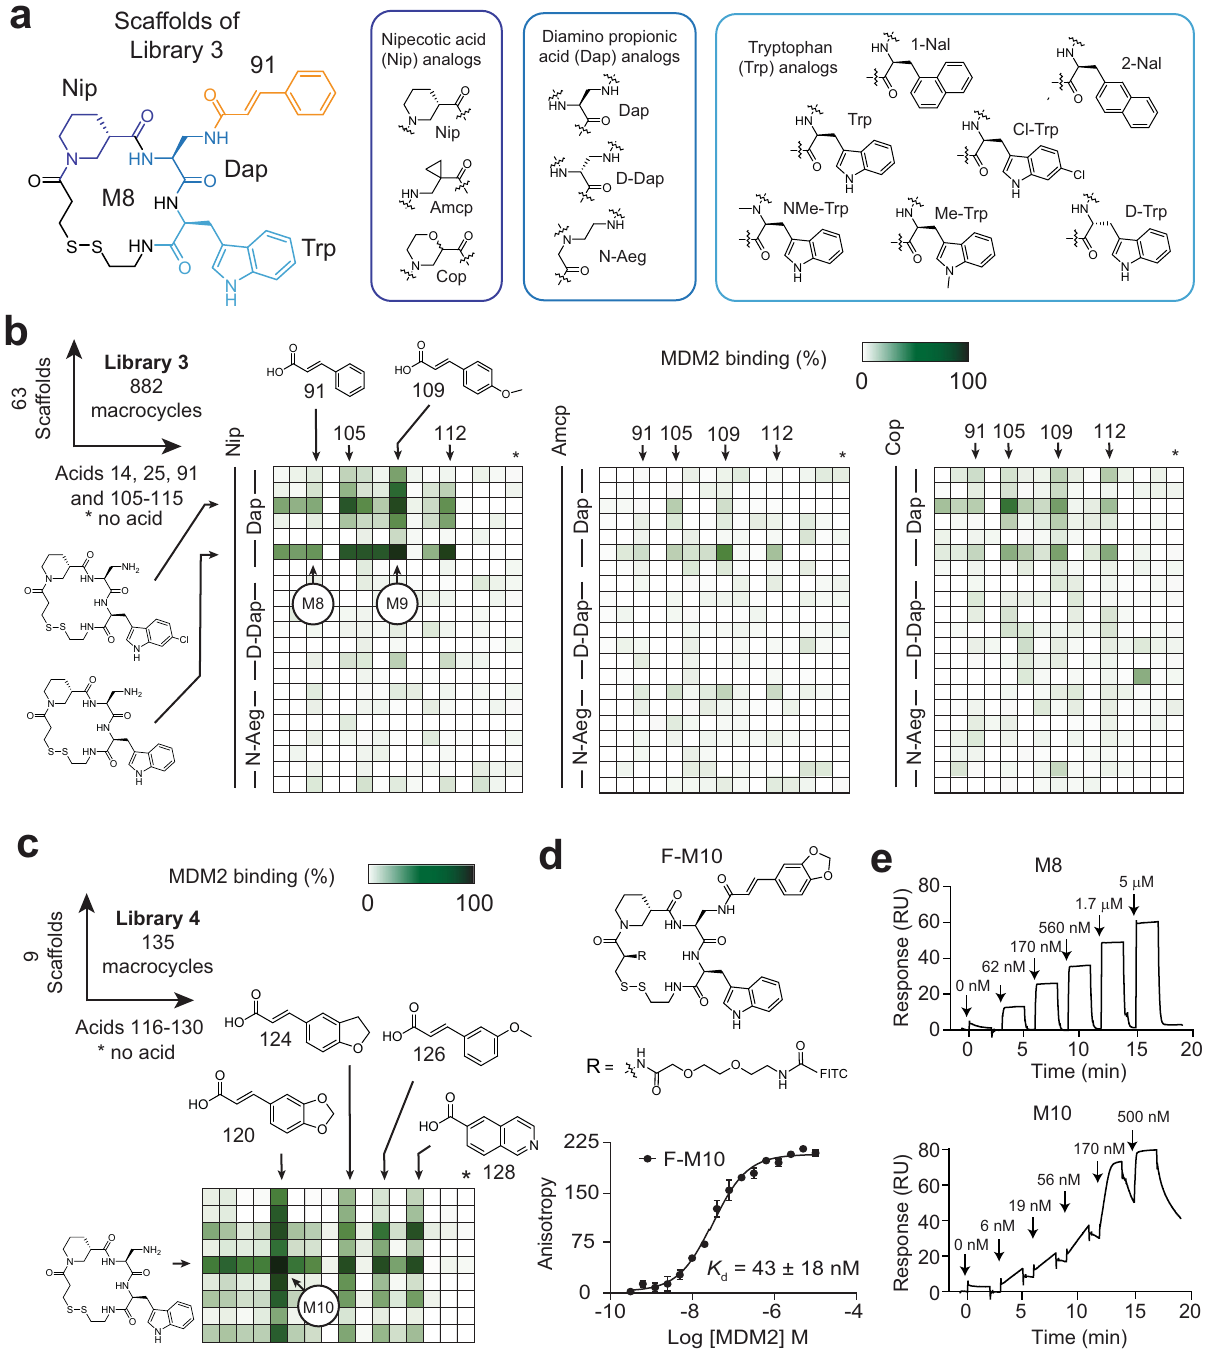
Fig. 5 Af fi nity optimization of an MDM2:p53 inhibitor. a Scaffolds of Library 3 are based on M8 wherein the amino acids shown in blue colors are diversi fi ed. Amino acid building blocks are shown in the three frames. b Heatmaps of MDM2 binding to the 63 scaffolds that were combinatorially acylated with 15 carboxylic acids at a 30 pmol scale. Binding to MDM2 was measured by displacement assay of the fl uorescent peptide probe by macrocycles at a concentration of 750 nM. c Screening of Library 4 based on the best nine scaffolds from the previous screens and 15 additional carboxylic acids. d Binding of fl uorescein-labeled and HPLC-puri fi ed macrocycle M10 (F-M10) to MDM2 as measured by FP. Mean values and SDs of three independent measurements of the binding by FP are shown. e Binding of unlabeled macrocycles M8 and M10 to MDM2 as measured by